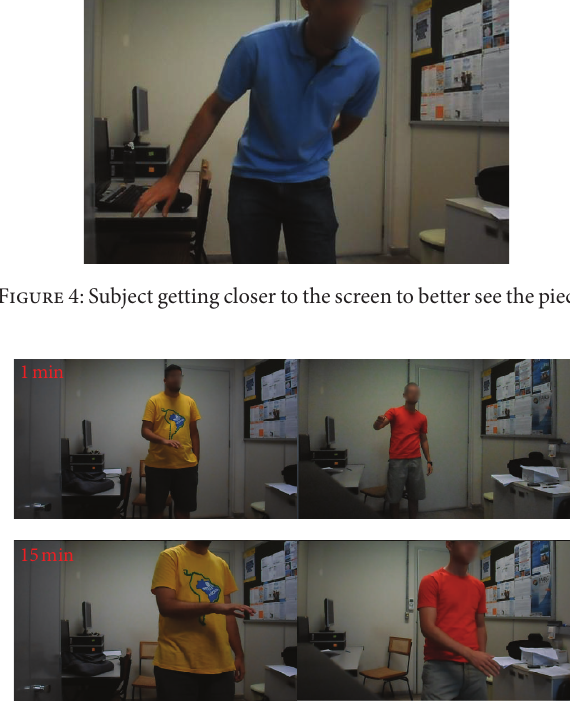
Figure 5: Subjects tending to remain closer to the